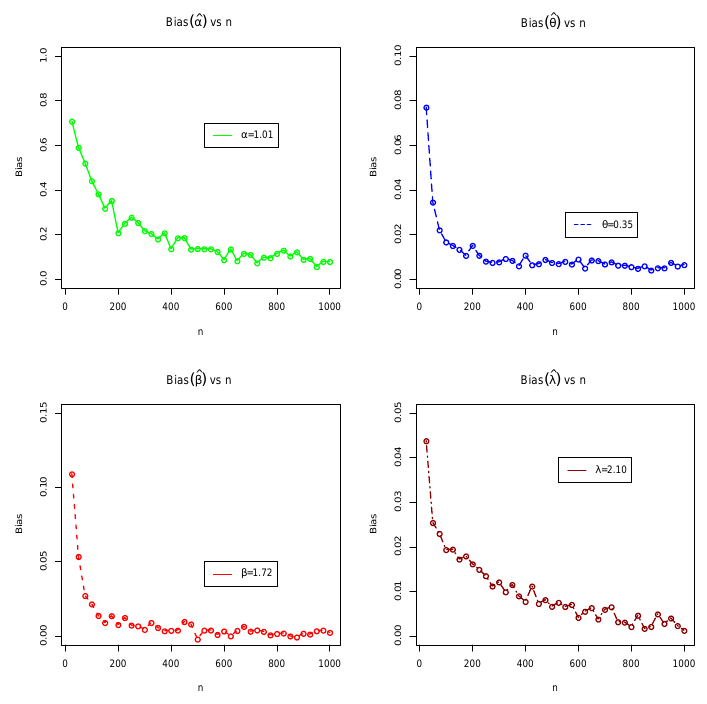
Figure 7. For set 2, α = 1.01, θ = 0.35, β = 1.72, λ = 2.10, bias plots of the